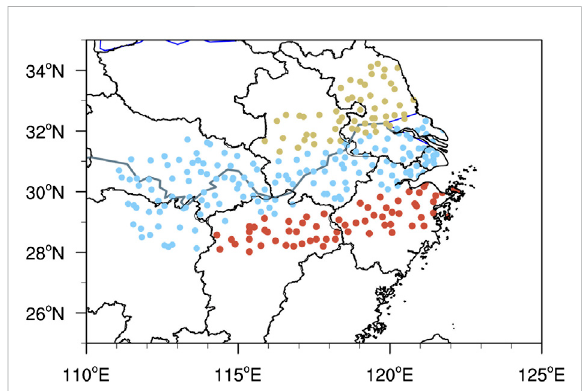
FIGURE 1 Distribution of CMA stations over the Meiyu region (red dots: Jiangnanarea;bluedots:middleandlowerreachesoftheYangtze River; yellow dots: Jianghuai